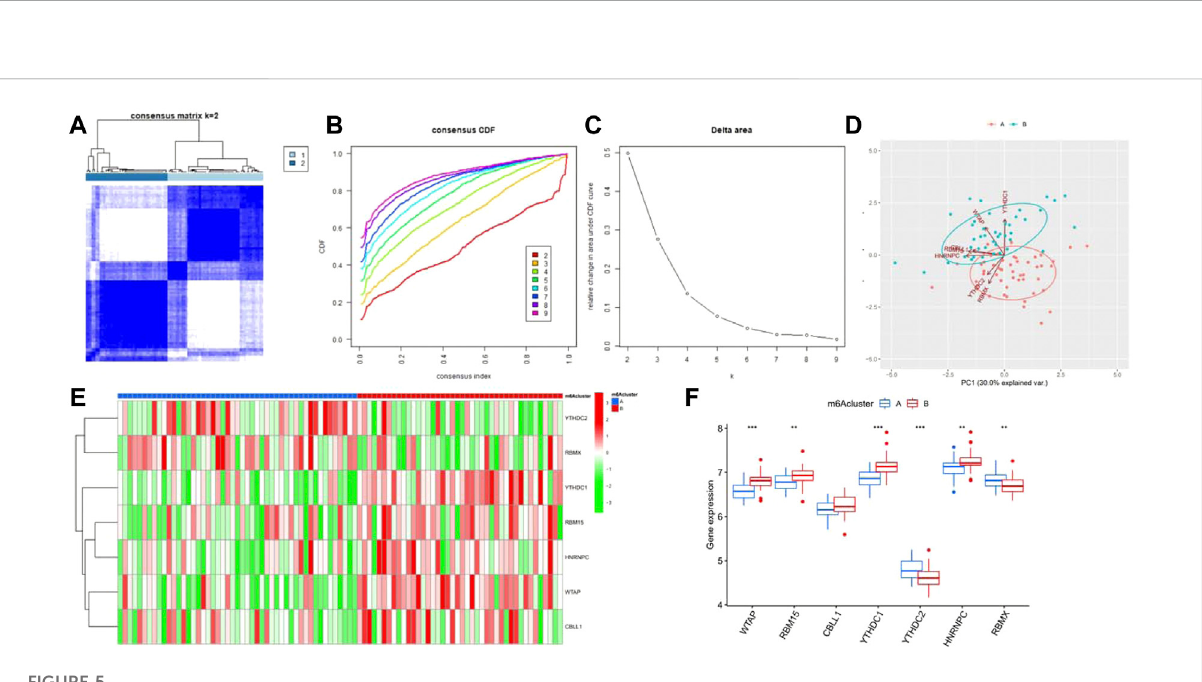
FIGURE 5 Consensus clustering of the signi fi cant RNA N6-methyladenosine (m6A) regulators in epilepsy. (A) Consensus score matrix of patients with epilepsy for k = 2. (B) Correlation between cumulative distribution functions. (C) Relative change in the area under the CDF curve for k = 2 – 9. (D) Principal component analysis for the expression pro fi les of the signi fi cant m6A regulators between the two m6A patterns. (E) Heatmap of seven signi fi cant m6A regulators between m6Acluster A and m6Acluster (B) (F) Differential expression of the seven signi fi cant m6A regulators between m6Acluster A and m6AclusterB. * p < 0.05, ** p < 0.01, and *** p <